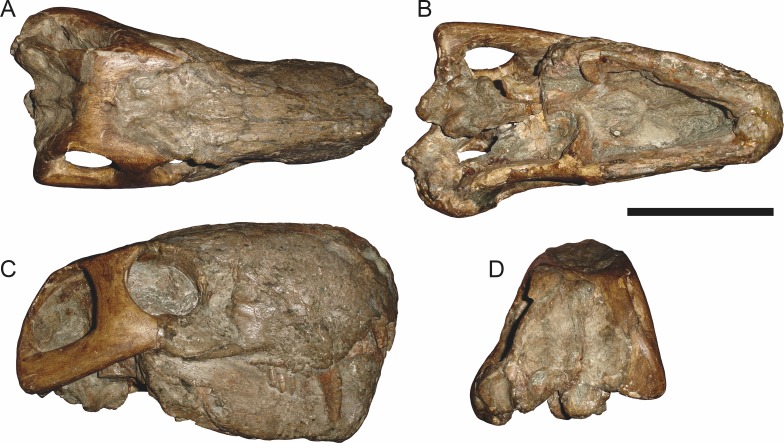
Referred specimen (BP/1/813) of Aelurognathus tigriceps (Broom & Haughton, 1913) in (A) dorsal, (B) ventral, (C) right lateral, and (D) occipital view.Holotype of Lycaenops alticeps
Brink & Kitching, 1953. Scale bar equals 10 cm.